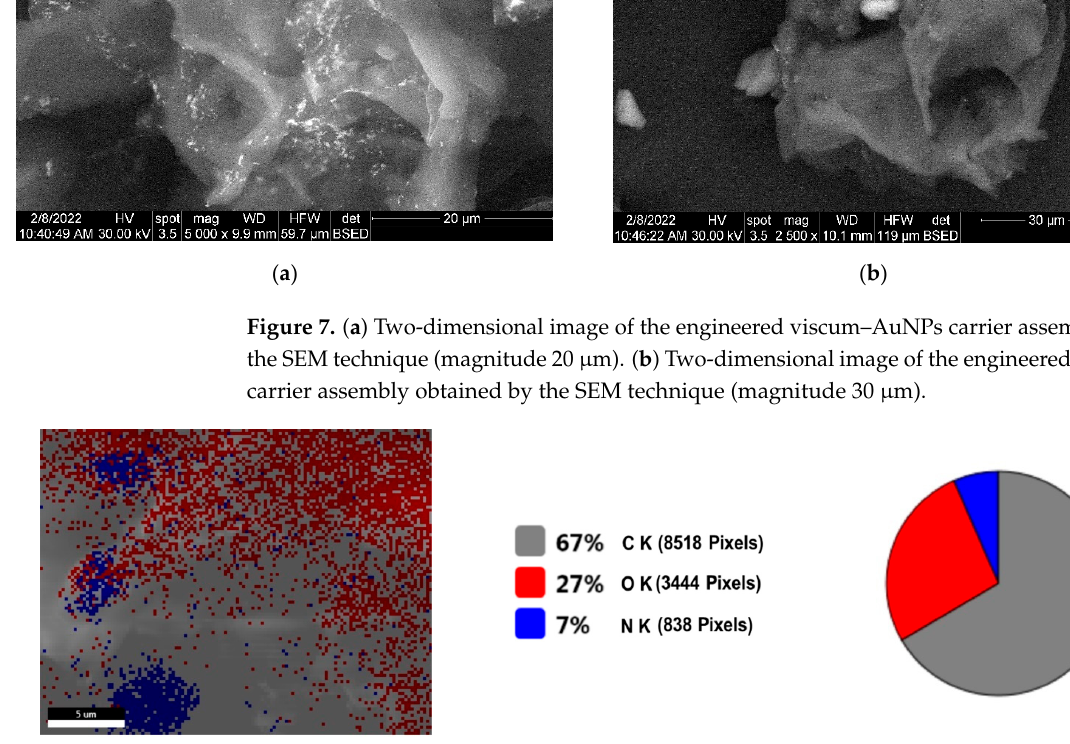
viscum–AuNPs carrier assembly [74].